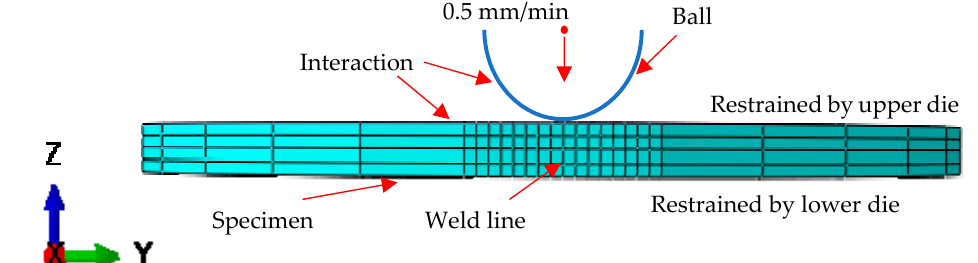
Figure 2. The schematic diagram of the small punch test (SPT).